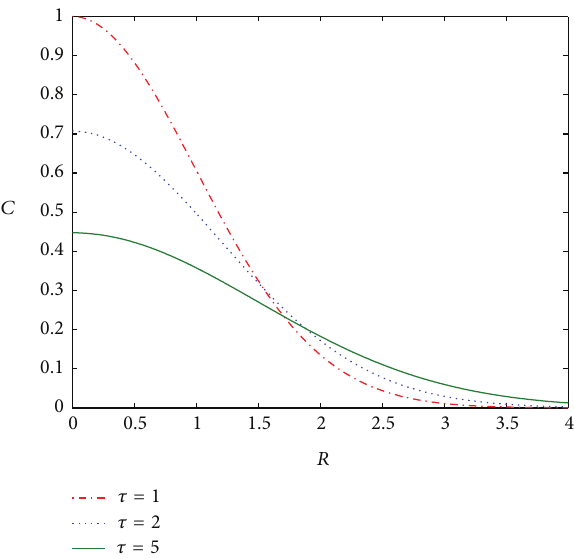
Figure 4: Contaminant concentration profile at various fixed